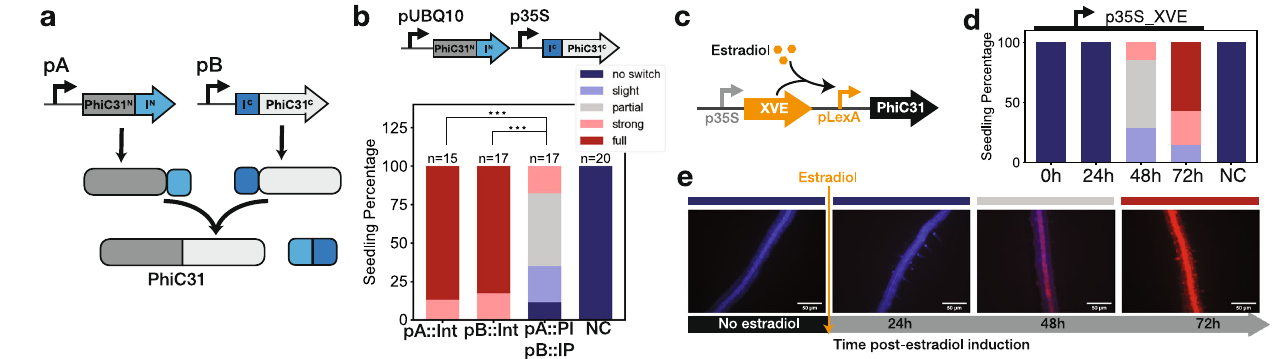
Fig. 6 | Split-intein and inducible promoters as additional tools to tune and induce the integrase switch. a Schematicofthe split-intein integrase system. The systemiscomposedoftwoconstructs:(i)promoterAdrivingtheN-terminalhalfof the integrase (PhiC31 N , dark gray) fused to the N-terminal portion of the intein protein (I N : Npu DnaE N , light blue) and (ii) promoter B driving the C-terminal por- tion of the intein (I C : Ssp DnaE C , darkblue)fusedto C-terminalhalf ofthe integrase (PhiC31 C , light gray). When the two constructs are expressed, the inteins auto- catalyzetrans-splicing,covalentlyjoiningthetwopartsofPhiC31. b Thesplit-intein system reduces the ef fi ciency of the integrase switch. Following the nomenclature of( a ),pUBQ10=promoterAandp35=promoterB.Theintegraseswitchef fi ciency of the split-intein system is compared with the full integrase expressed with pro- moter A alone (pUBQ10: PhiC31) and with promoter B alone (p35S:PhiC31). NC corresponds to the target line without integrase. T1 seedling phenotypes are determinedwith fl uorescentmicroscopyimagesandcategorizedfromnoswitchto